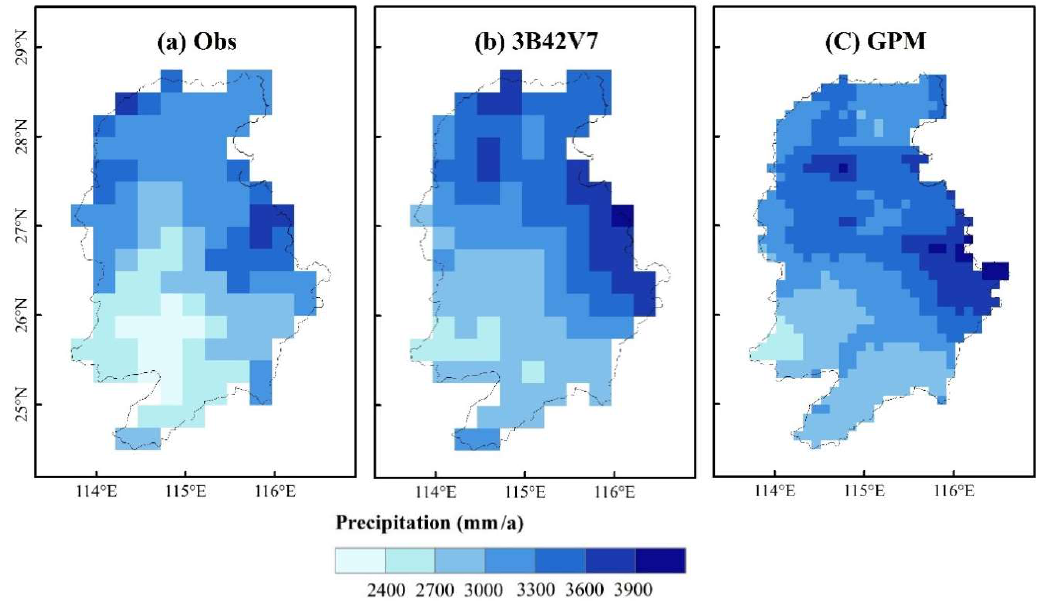
Figure 3. Spatial distribution of annual mean precipitation in the Ganjiang River Basin from GPM, 3B42V7 and Observed data from 2014 to 2015 ( a ) Observed data; ( b ) 3B42V7; ( c ) GPM).